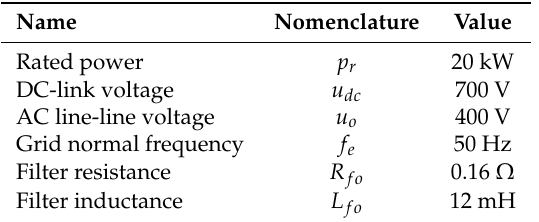
Table 1. List of parameters of the power converter under